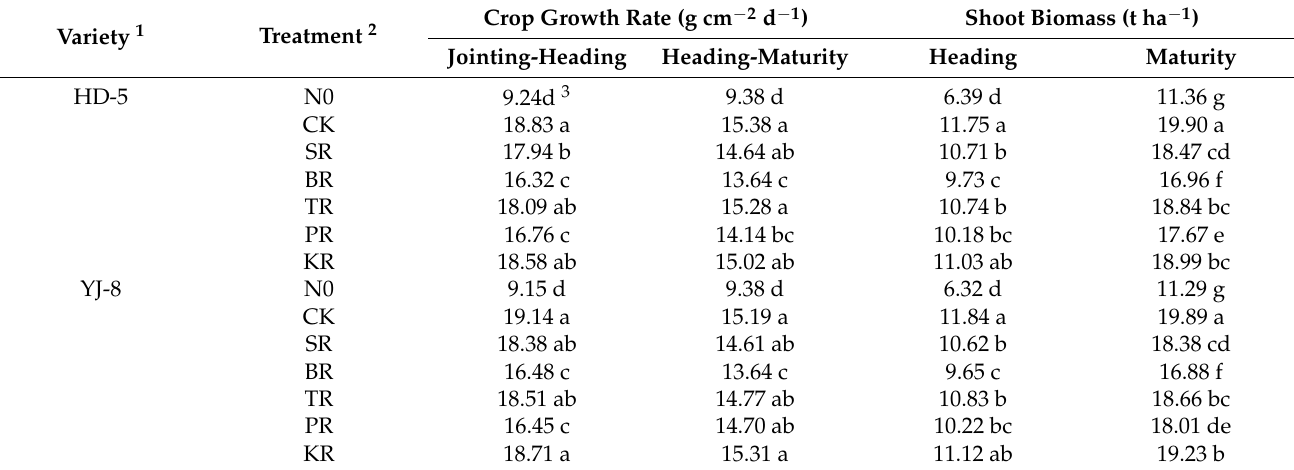
Table 5. Crop growth rate and shoot biomass subjected to various N reduction treatments. Variety